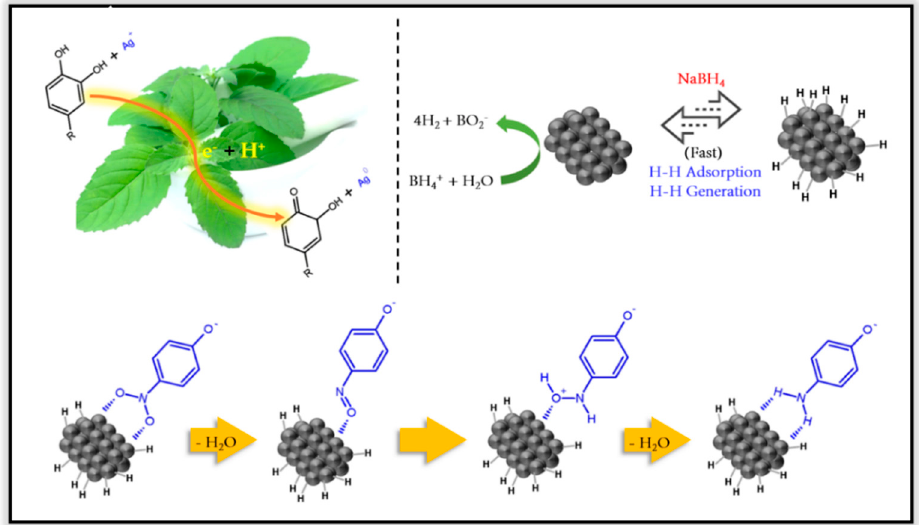
Figure 2. Phyto-synthesis of SNPs and catalytic reduction of p -nitrophenol (PNP) on SNPs surface in presence of sodium borohydride.